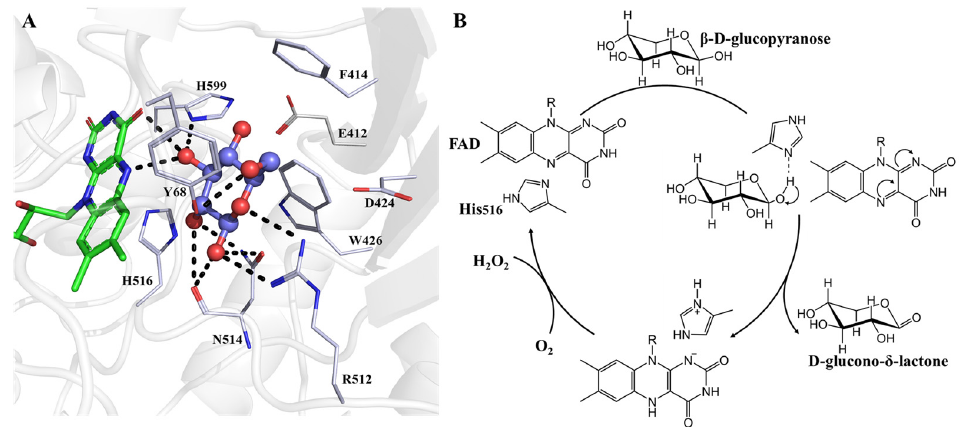
Figure 2. ( A ) The active site and amino acid residues of the oxidized form of the GOX from Aspergillus niger (PDB:1CF3) in the present of β - D -glucose. ( B ) Reaction scheme of glucose oxidation catalyzed by glucose oxidase.